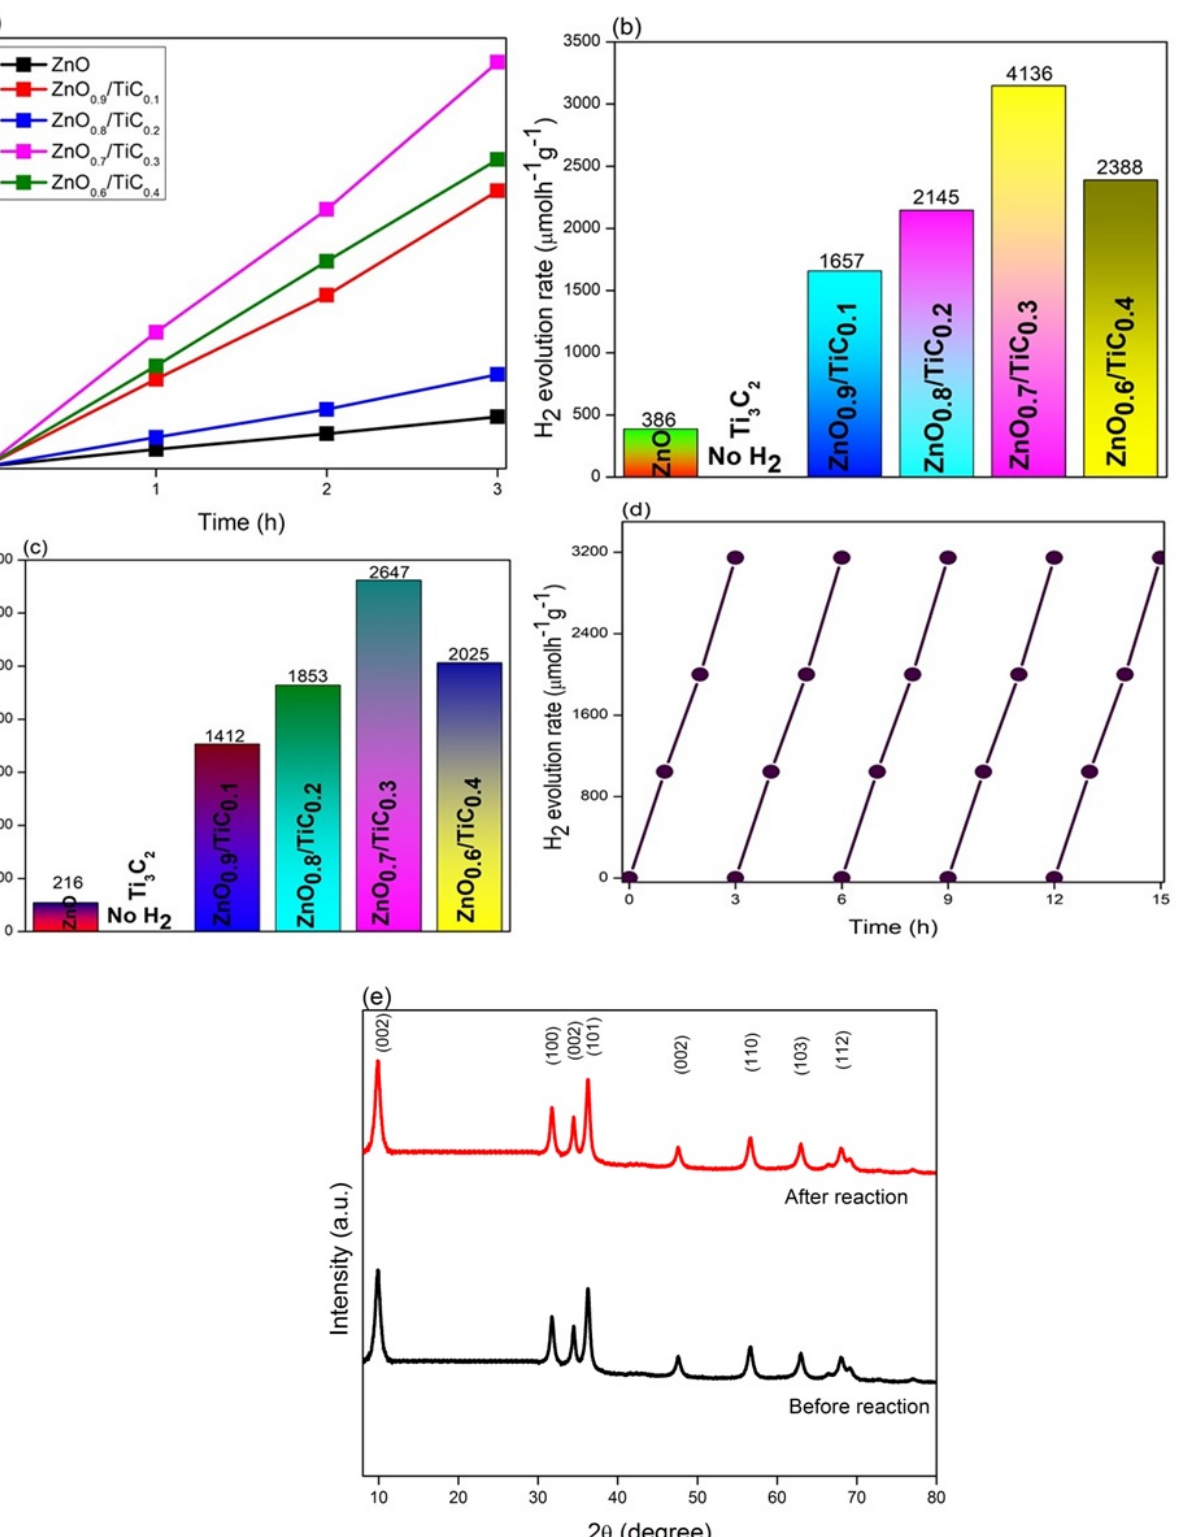
Figure 5. The photocatalytic H 2 evolution activity of the ZnO and ZnO/Ti 3 C 2 composites using ( a , b ) water–ethanol mixture; ( c ) pure water; ( d ) the photocatalytic H 2 evolution stability tests of ZnO 0.7 /TiC 0.3 composite; and ( e ) XRD patterns of ZnO 0.7 /TiC 0.3 composite before and after reaction.